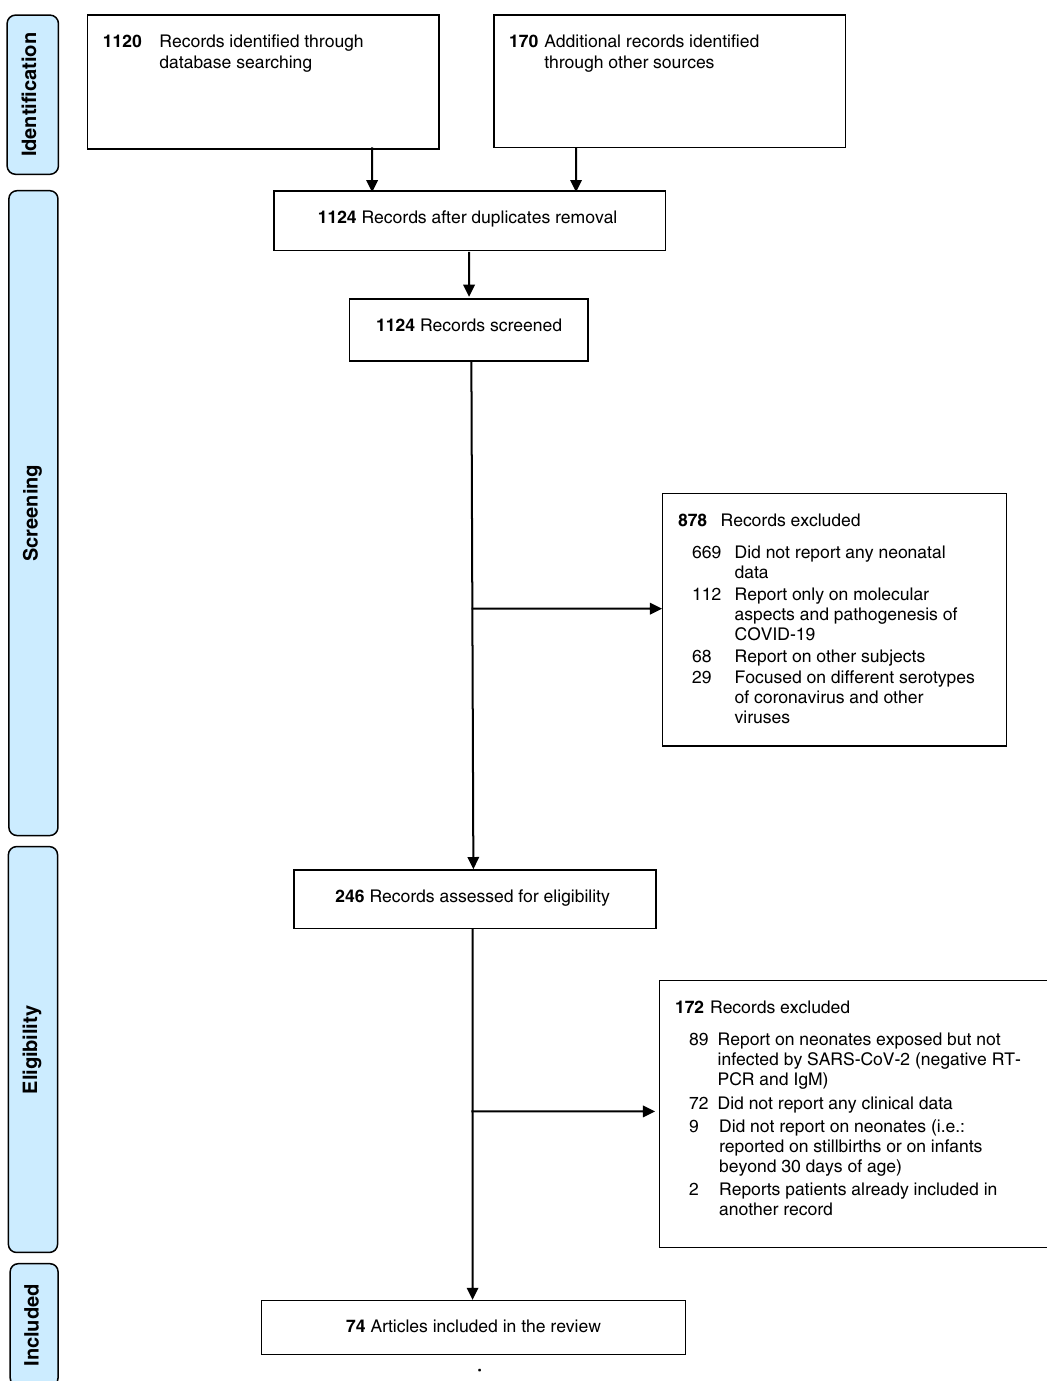
Fig. 1 Study fl ow chart. Flow chart prepared according to the PRISMA guidelines template for